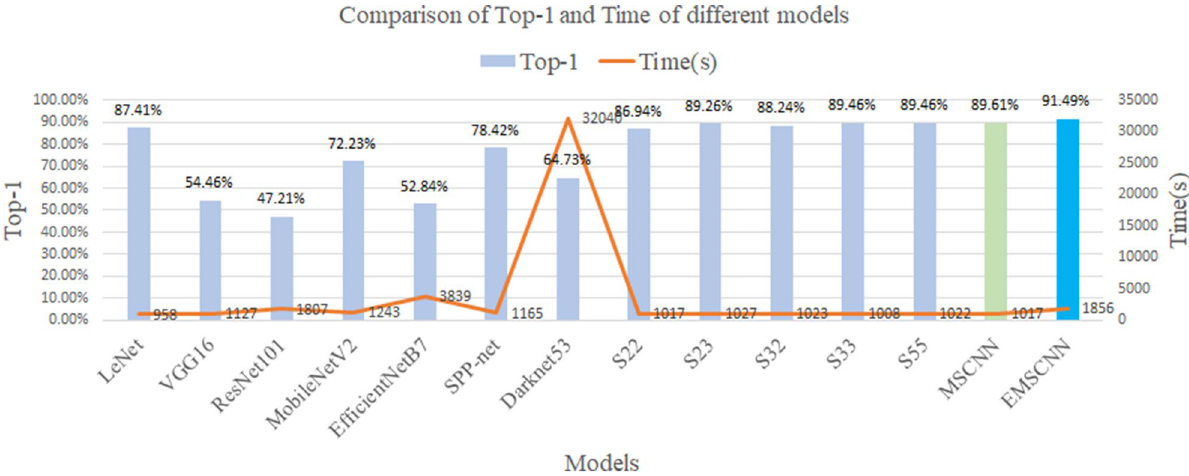
Figure 7. Comparison of Top-1 and Time of different